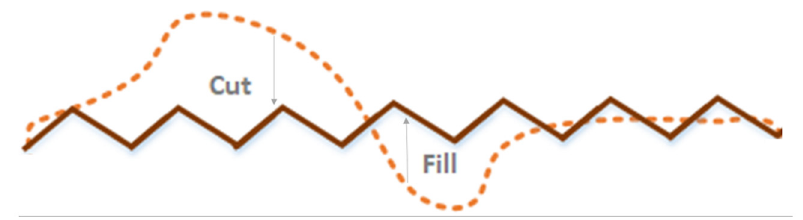
Figure 8. Differential DTM profile: DTM before the tillage operation (dashed line); DTM of soil tillage (filled line); and fill and cut volumes.